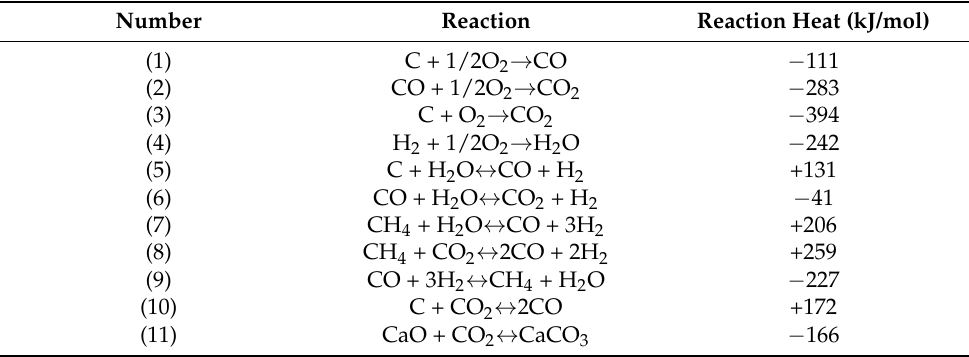
Table 2. Main reactions that occurred in the